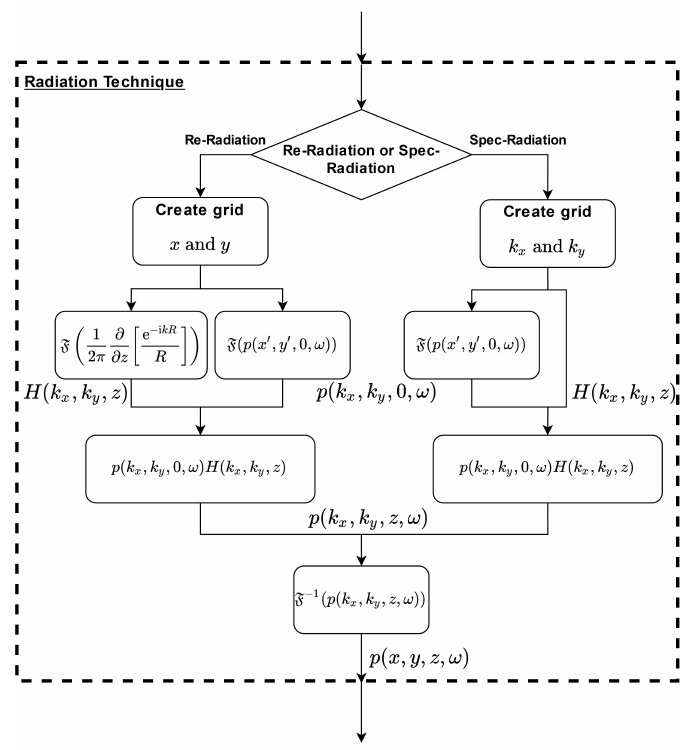
Figure 3. Flow chart of the flow chart block of the radiation technique (see Figure 2) for the practical realization of the spec-radiation and re-radiation